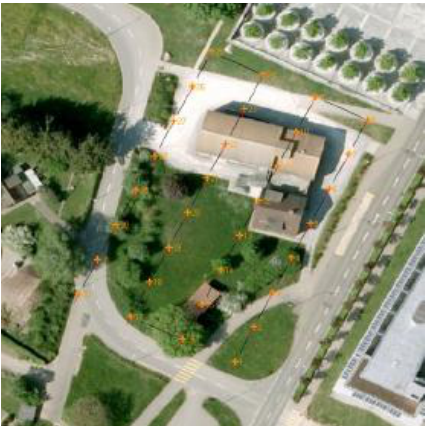
Figure 2. Flight planning of the test area Campus Science City ETH Hoenggerberg